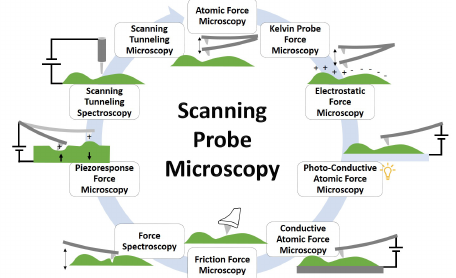
Figure 1. Scheme showing the different Scanning Probe Microscopy techniques described in this review for the characterization of two-dimensional (2D)